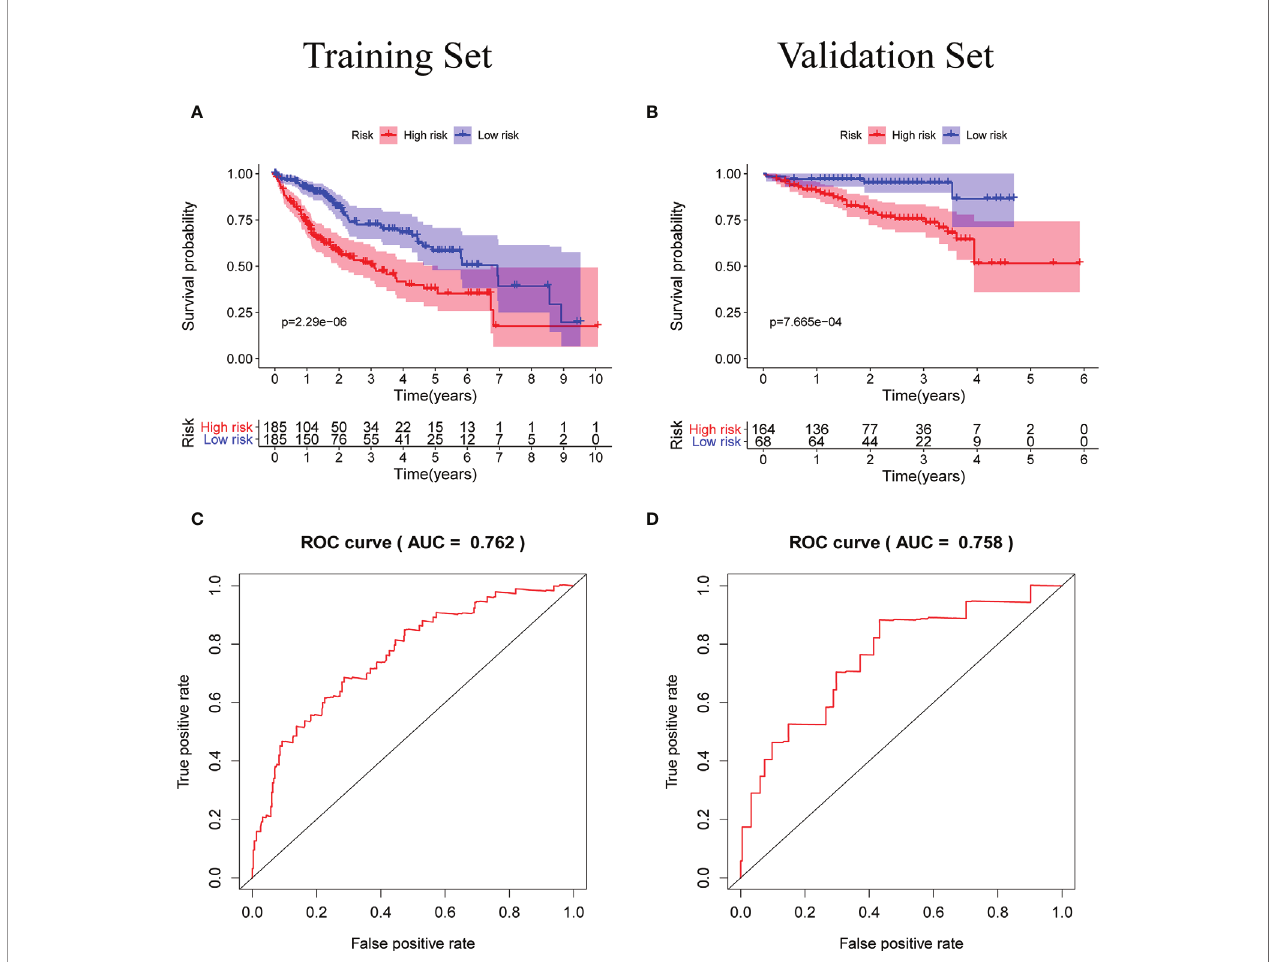
FIGURE 5 | (A, B) Kaplan-Meier survival curves of the training set and the validation set, the survival prognosis of the patients in the high-risk group was signi fi cantly worse than that of the patients in the low-risk group ( P < 0.05). (C, D) The ROC curve of the prognostic model, the results of the training set (AUC = 0.762) and the validation set (AUC = 0.758) show that the predictive ability of the model is good. (The meaning of AUC value: 0.5-0.7 indicates acceptable predictive ability, 0.7-0.9 indicates good predictive ability, >0.9 indicates excellent predictive